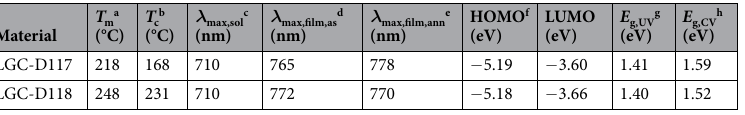
Table 1. Thermal, optical, and electrochemical properties of LGC-D117 and LGC-D118. a Melting temperature. b Crystallization temperature. c Measurements in chlorobenzene solution. d Measurements in films were spin- casted on the glass before annealing. e Measurements in films were spin-casted on the glass after annealing. f The HOMO level was estimated from cyclic voltammetry measurement. g Optical band gap was determined from onset of the absorption in film. h Electrochemical band gap was estimated by cyclic voltammetry measurement.